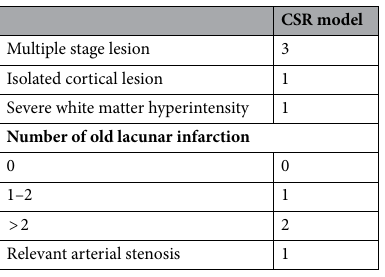
Table 1. Comprehensive stroke recurrence (CSR)